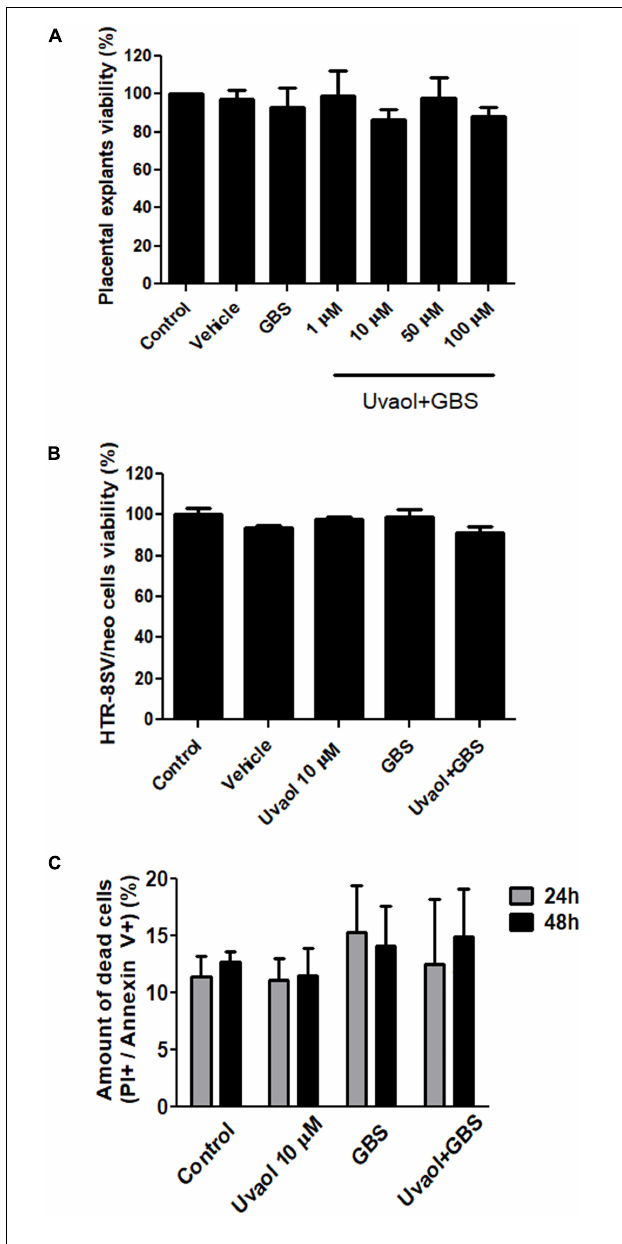
FIGURE 1 | Uvaol does not affect cells and explant viability. (A) The term chorionic villi explants were treated with DMSO (vehicle), GBS at 10 6 CFU (GBS), or with uvaol at 1, 10, 50, and 100 µ M for 24 h and analyzed by MTT assay. (B) The HTR-8/SVneo cells were treated with vehicle, 10- µ M uvaol, GBS at 10 6 CFU or both for 24 h, and analyzed by MTT assay. (C) Cells were treated for 24 h and 48 h, and annexin V/PI staining was analyzed through flow cytometry. Bar graphs represent mean values ± S.E.M.; n = 4 in triplicate in panel (A,B) , and n = 3 in duplicate in panel (C) . One-way ANOVA with Tukey post hoc test was used in panel (A,B) , whereas two-way ANOVA with Bonferroni post hoc test was used in panel (C) .